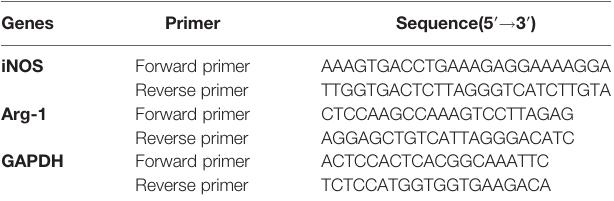
TABLE 1 | The primers of quantitative RT-PCR.